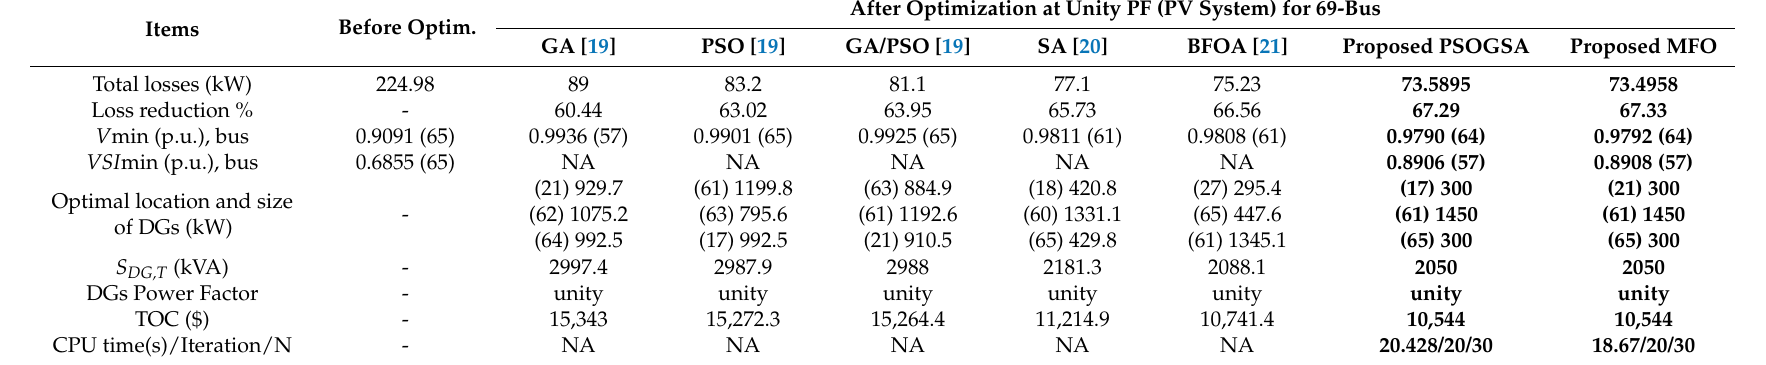
Table 6. The results of 69-bus IEEE distribution network at unity PF (PV type). Bold items represent the numerical results based on PSOGSA and